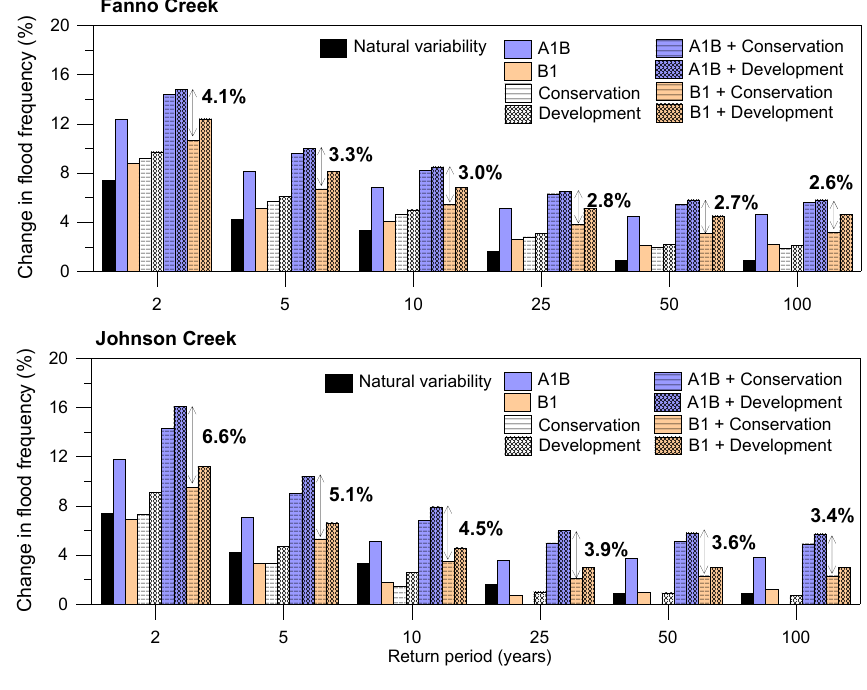
Fig. 9. Ensemble mean of changes (%) in flood frequency under different scenarios for 4 the 2050s with respect to the reference period of 1960-1989. 5